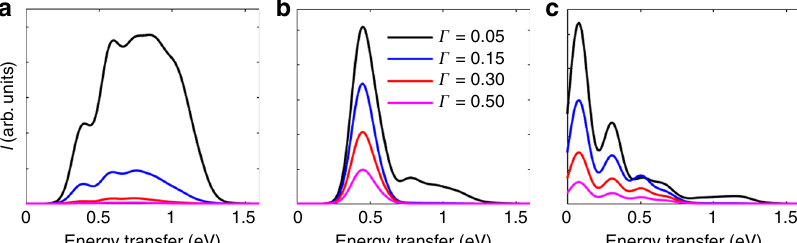
Fig. 4 The effect of the core-hole lifetime on the RIXS spectra. The variation in the computed RIXS intensity at momentum transfer a q = 0, b q = π /2 a , and c q = π / a . As the core-hole lifetime is decreased (increasing Γ ), the four-spinon excitations at q = 0 disappear rapidly, while the two-spinon contributions to the spectra at q = π /2 a and q = π / a are more robust. The intensity scale is reported in arbitrary units (arb.